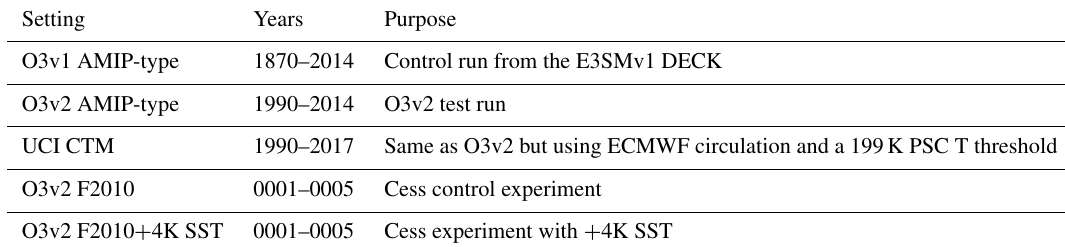
Table 1. List of simulation configurations and periods and a brief explanation of their purposes. Setting Years